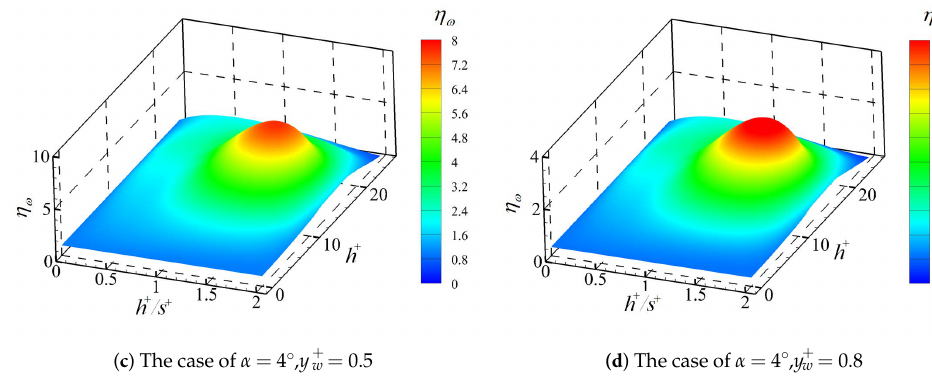
Figure 6. Functional relationship between η ω and riblet geometry.